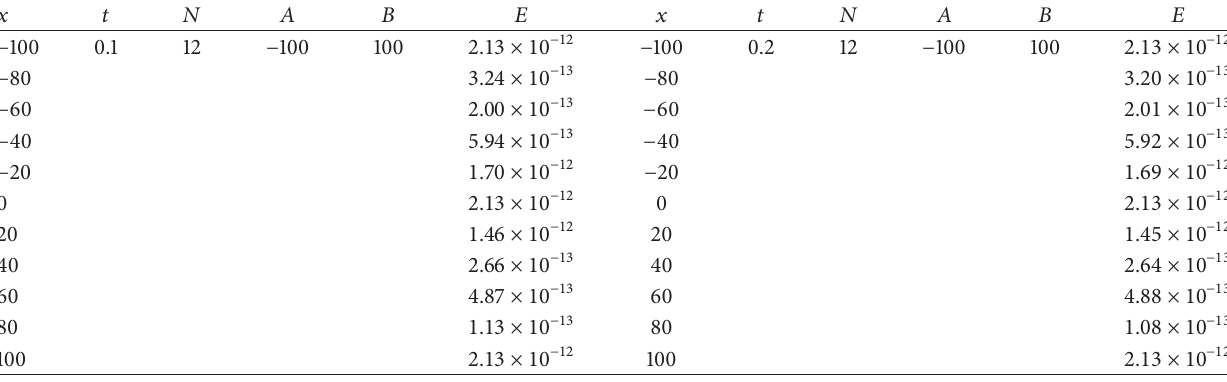
Table 5: Absolute errors with 𝜃 = 𝜗 = −1/2 , 𝑁 = 12 and various choices of 𝑥, 𝑡 for Example 3 for 𝜏 = 0.5 , 𝜆 1 = 0.01 , and 𝑠 = 5